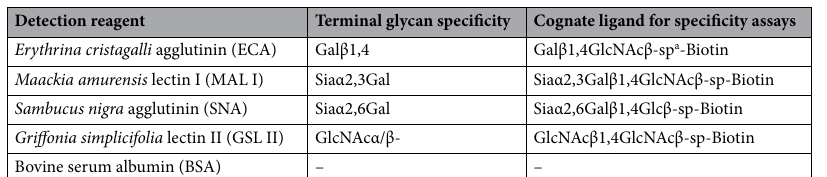
Table 1. Detection reagents and specificities. a sp = –O(CH 2 ) 3 NHCO(CH 2 ) 5 NH–.